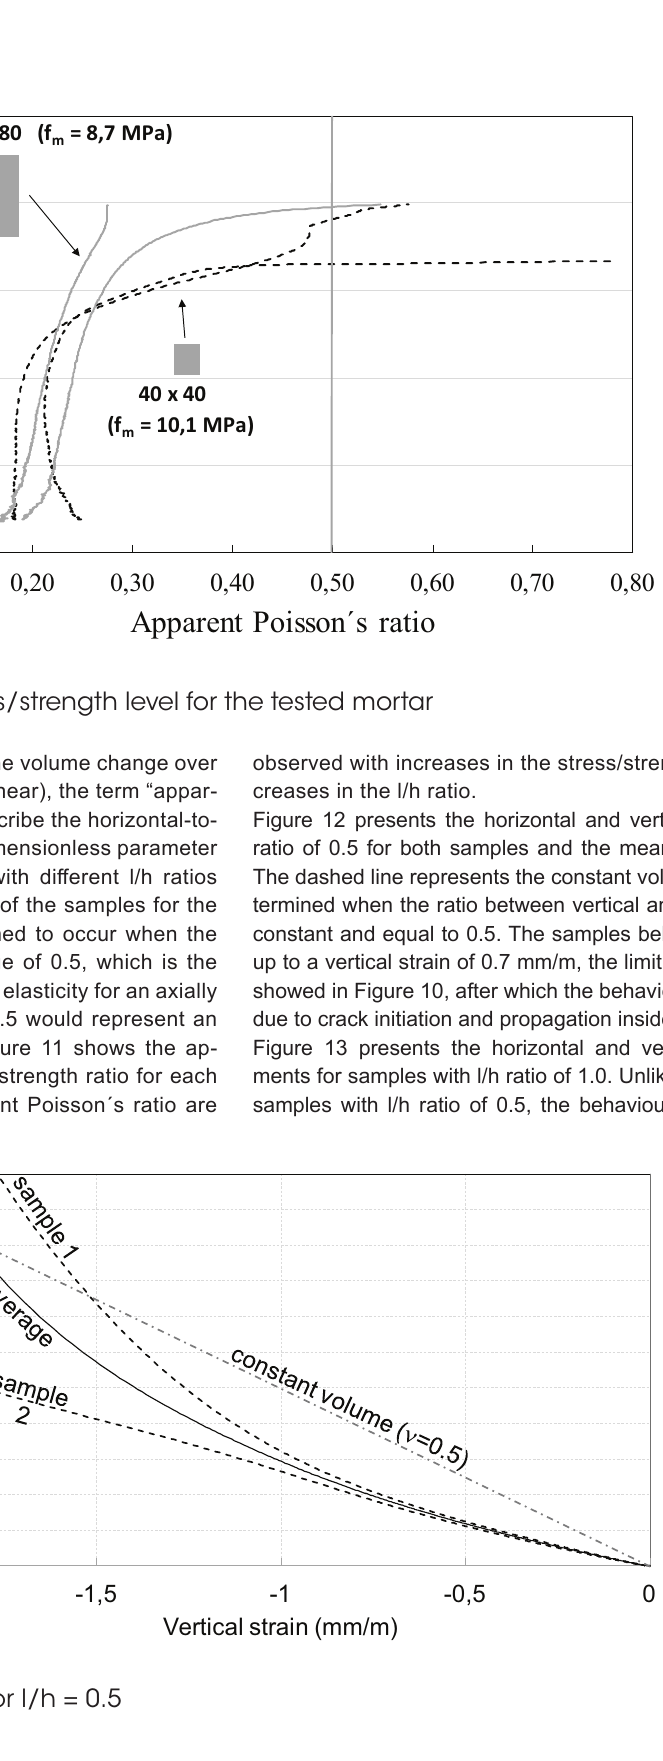
Horizontal versus vertical strains for l/h =